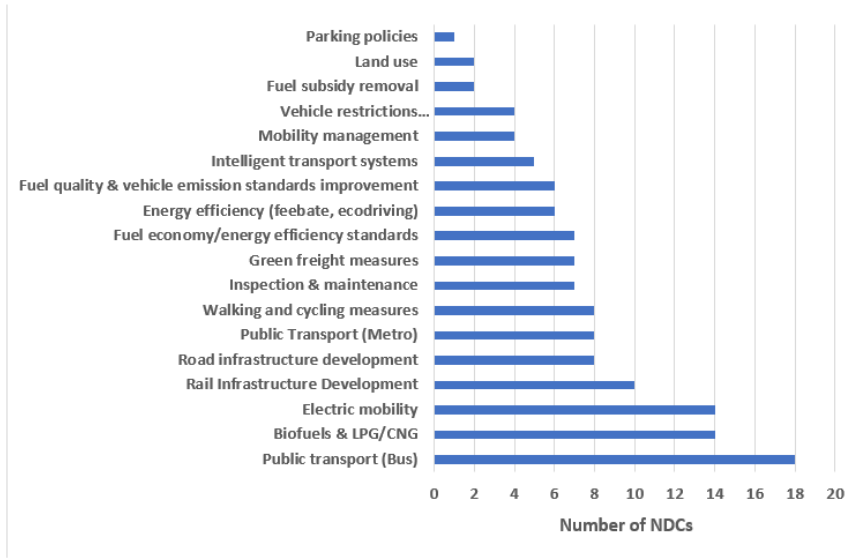
Figure 2. Transport polices reflected in NDCs of Asian countries. Source: Compiled from